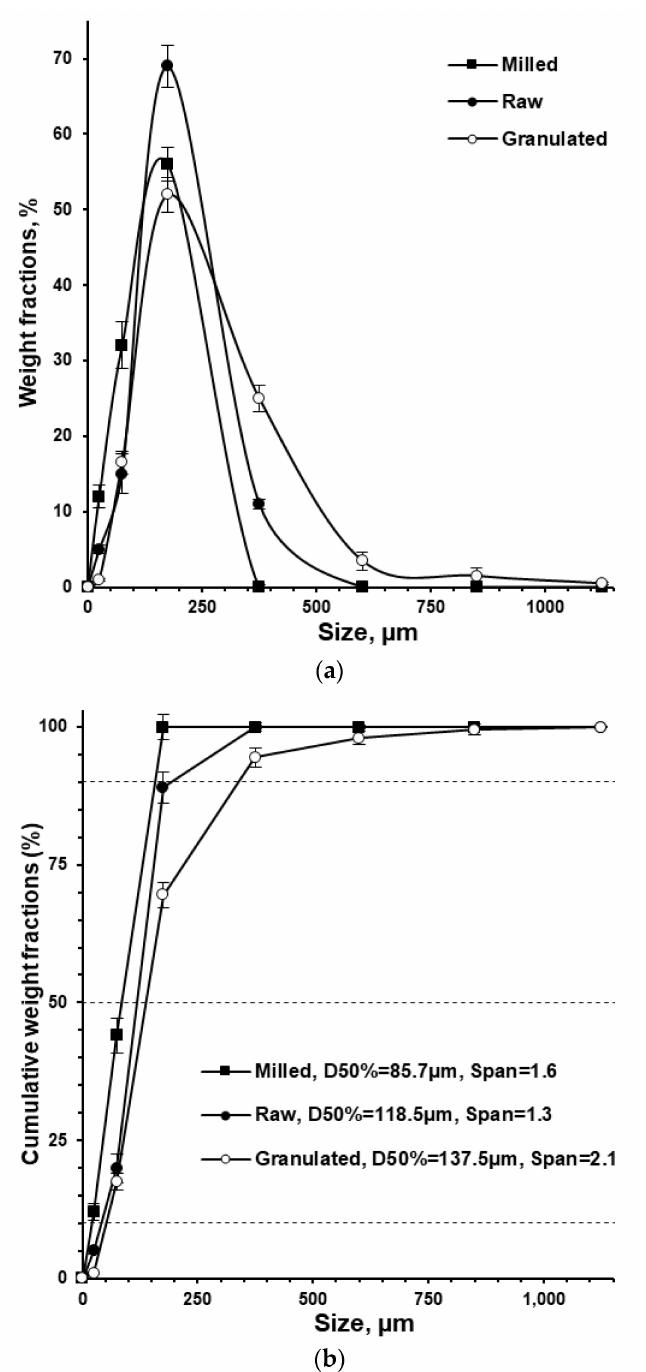
Figure 2. Particle size distribution ( a ) and cumulative weight fractions ( b ) of raw, milled, and granulated isoniazid ( n =